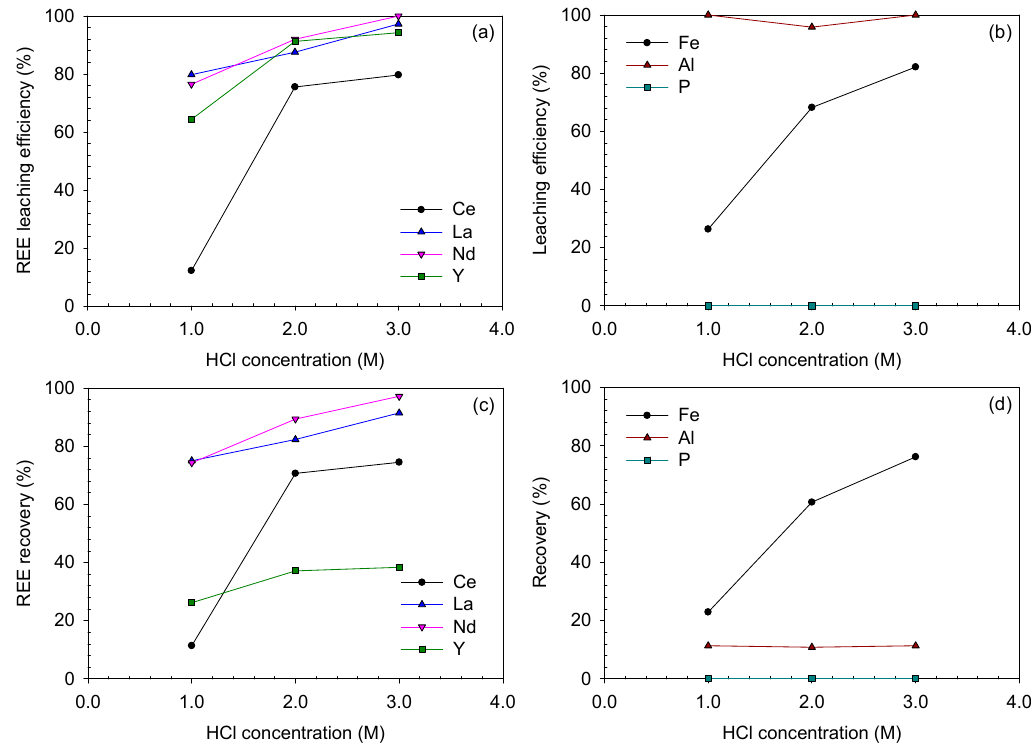
(M)0.0 HCl concentration Figure 15. Leaching efficiencies and recoveries after acid-leaching of the caustic digested ore at HCl Figure 15. Leaching e ffi ciencies and recoveries after acid-leaching of the caustic digested ore at HCl concentrations of 1.0–3.0 M and 80 °C for 3 h (digested using 50 wt% NaOH solution for 3 h): ( a ) REE concentrations of 1.0–3.0 M and 80 ◦ C for 3 h (digested using 50 wt% NaOH solution for 3 h): ( a ) REE and ( b ) Fe-, Al- and P-leaching e ffi ciencies (%); ( c ) REE and ( d ) Fe, Al and P recoveries and ( b ) Fe-, Al- and P-leaching efficiencies (%); ( c ) REE and ( d ) Fe, Al and P recoveries (%).